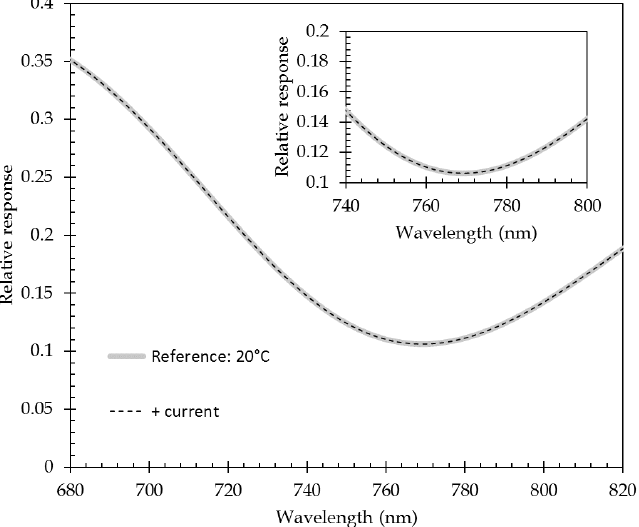
Figure 10. Effect of current injection (here, 318 mA) on the SPR response curve. In insert: zoom of the minimum of the response curve.